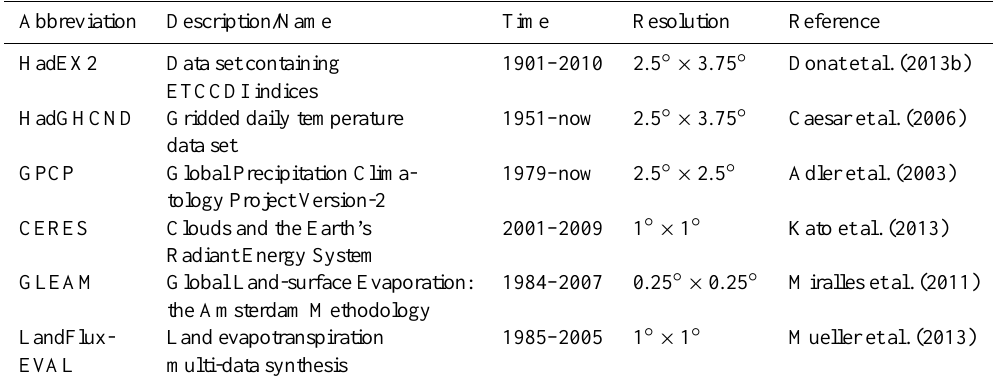
Fig. 10. T MAX and T MIN probability density functions for ACCESS1.3b and HadGHCND over Asia, Australia, Europe and North America for JJA (1951–2011) and skill scores for PDFs of T MAX and T MIN (as in Fig. 9). Table 2. Data sets used for